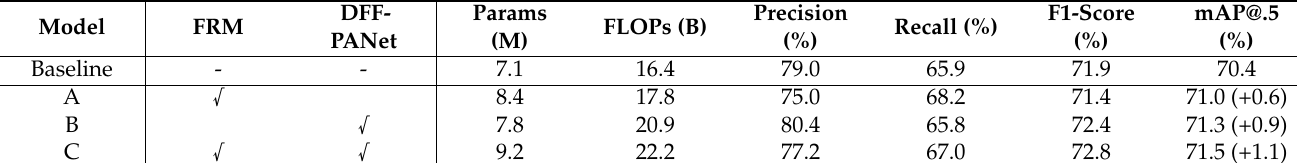
Table 8. Ablation results.